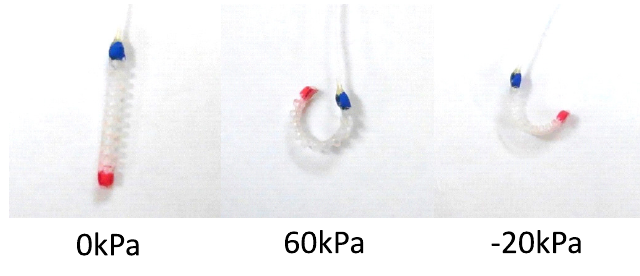
Figure 1. The moving of the actuator.